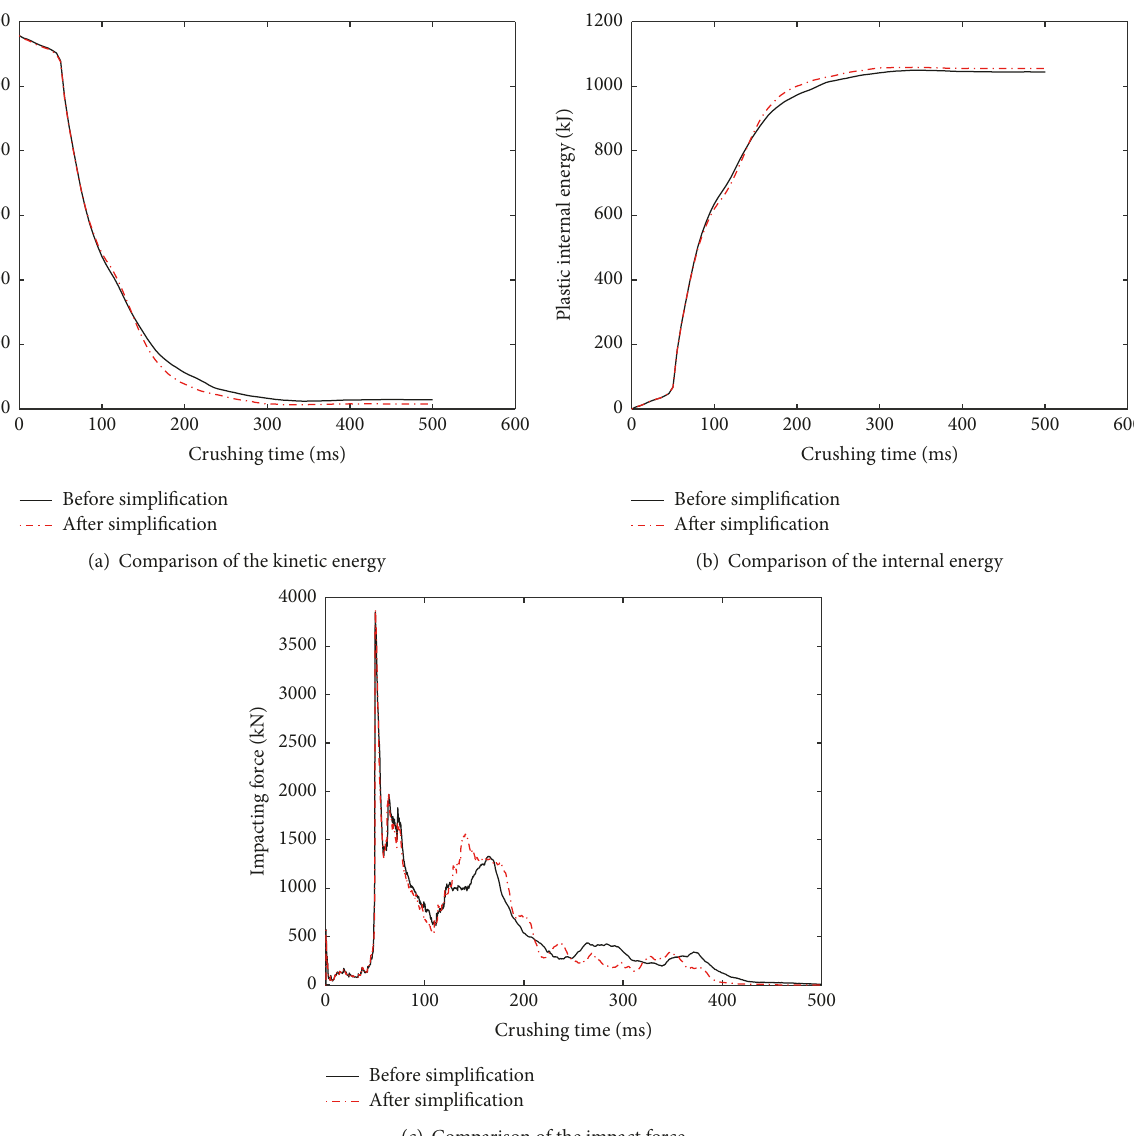
Figure 2: Comparative analysis of the collision data (head vehicle) before, and after, simplification.